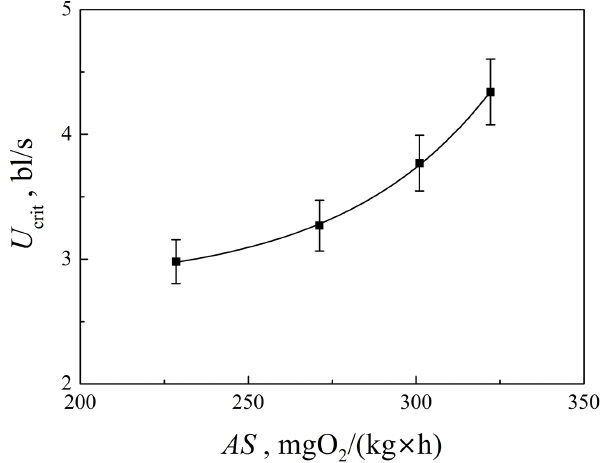
Figure 2. Variation of critical swimming speed ( U crit , mean ± S.E.) with aerobic scope ( AS ). The AS is the difference between maximum oxygen consumption rate and routine oxygen consumption rate.